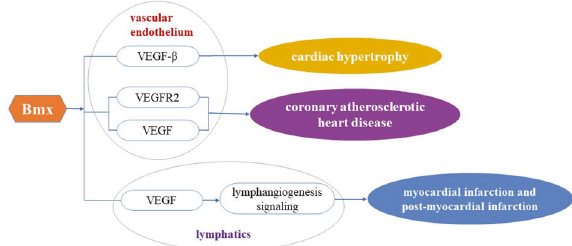
Fig. 4 The link of Bmx to cardiovascular disease mediated through VEGF signaling. VEGF vascular endothelial growth factor, VEGF- β vascular endothelial growth factor-beta, VEGFR2 vascular endothelial growth factor receptor